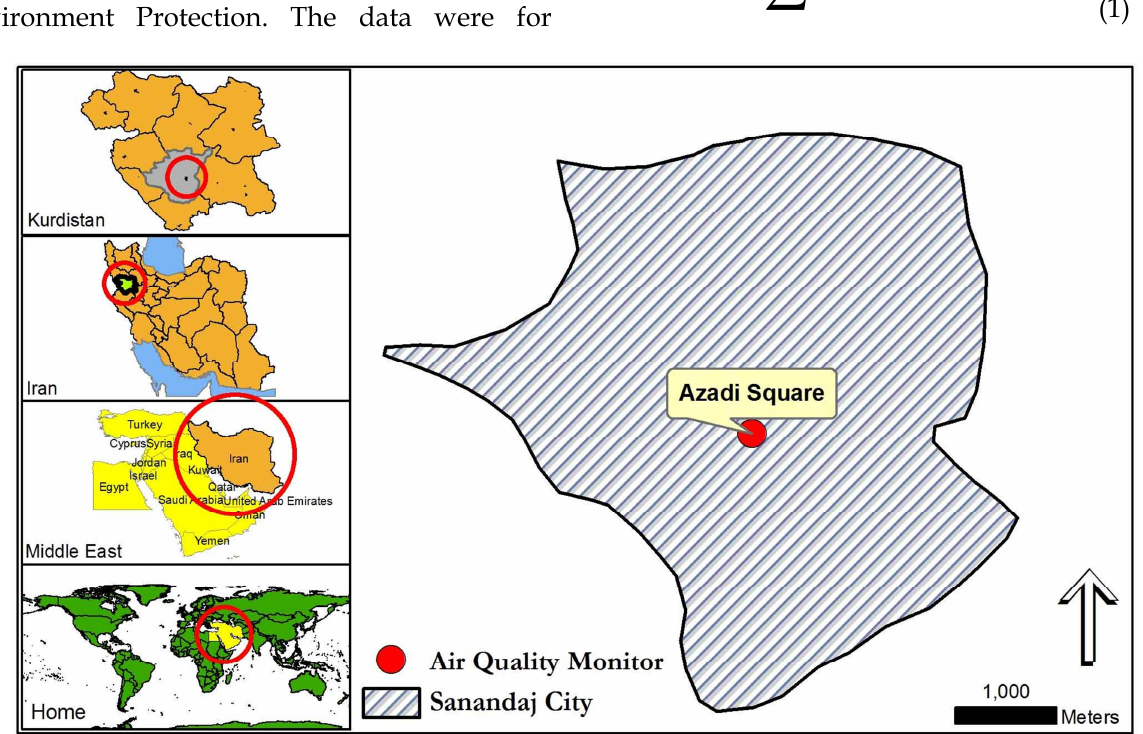
Figure 1. This study area of Sanandaj, Iran, and location of the air quality monitoring station in